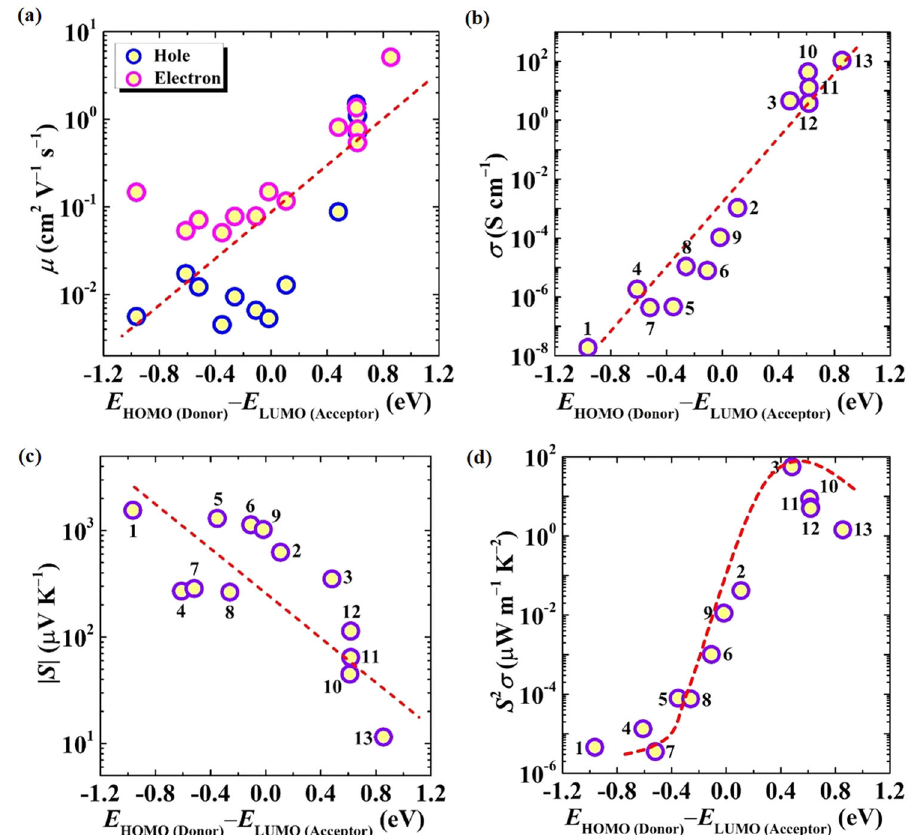
Fig. 5 Enhancing the charge transport and TE performance through engineering the energy levels of frontier molecular orbitals. The dependence of the room-temperature a mobility ( μ ), b conductivity ( σ ), c absolute value of Seebeck coef fi cient ( S j j ), and d power factor ( S 2 σ ) on the energy-level difference ( E HOMO ð Donor Þ (cid:2) E LUMO ð Acceptor Þ ) for our studied organic donor – acceptor complexes. The red dashed lines exhibit the